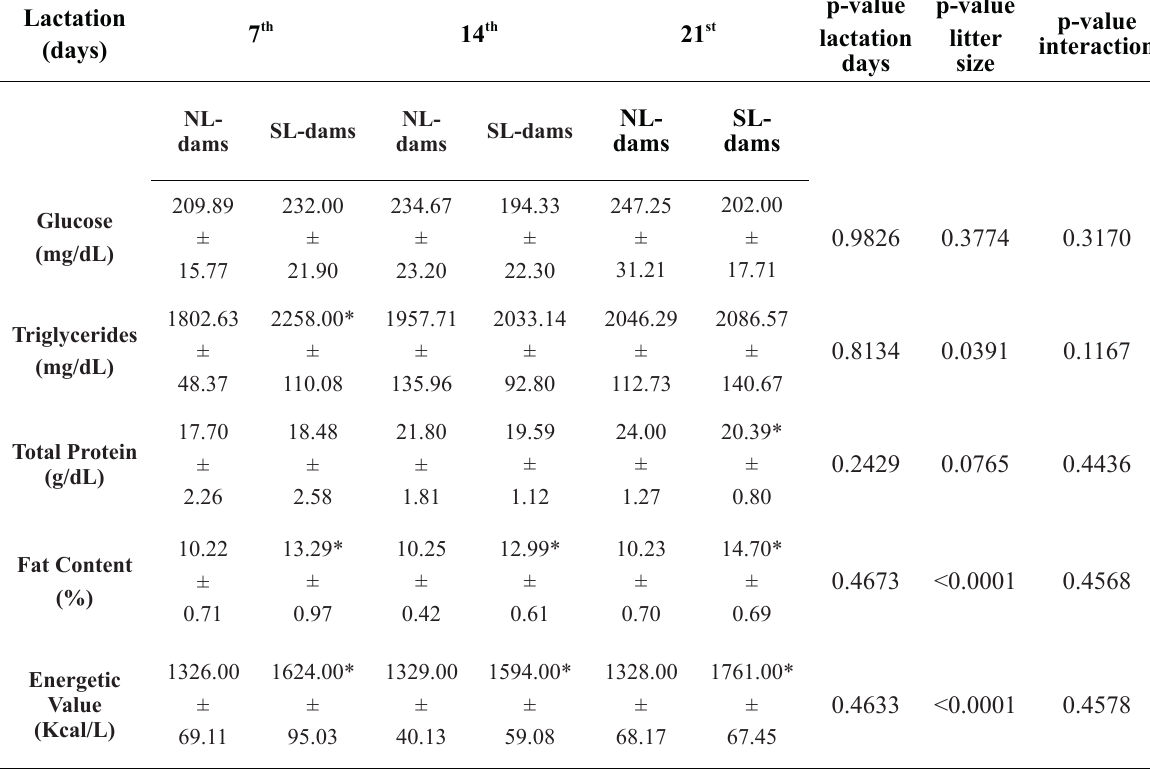
Milk composition during different lactation